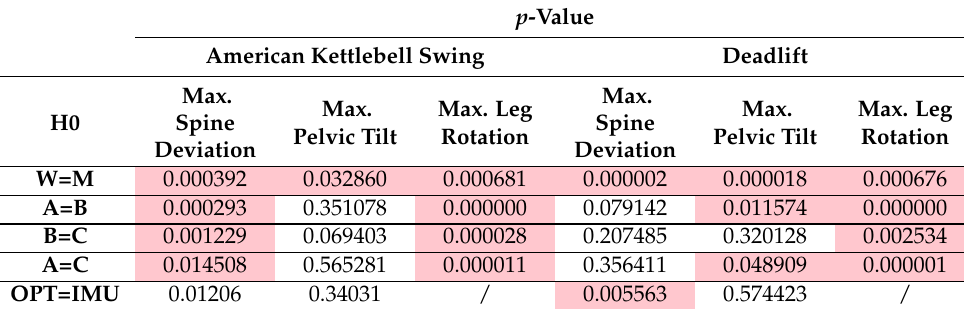
Table 4. p -value for several hypotheses ( p < 0.05 in red).